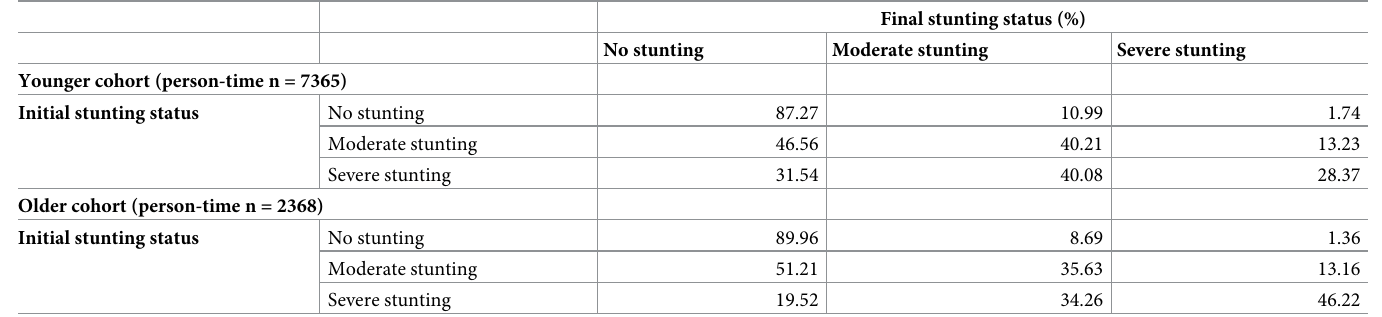
Table 3. Transition probabilities of stunting status from childhood to youthhood, Ethiopia,